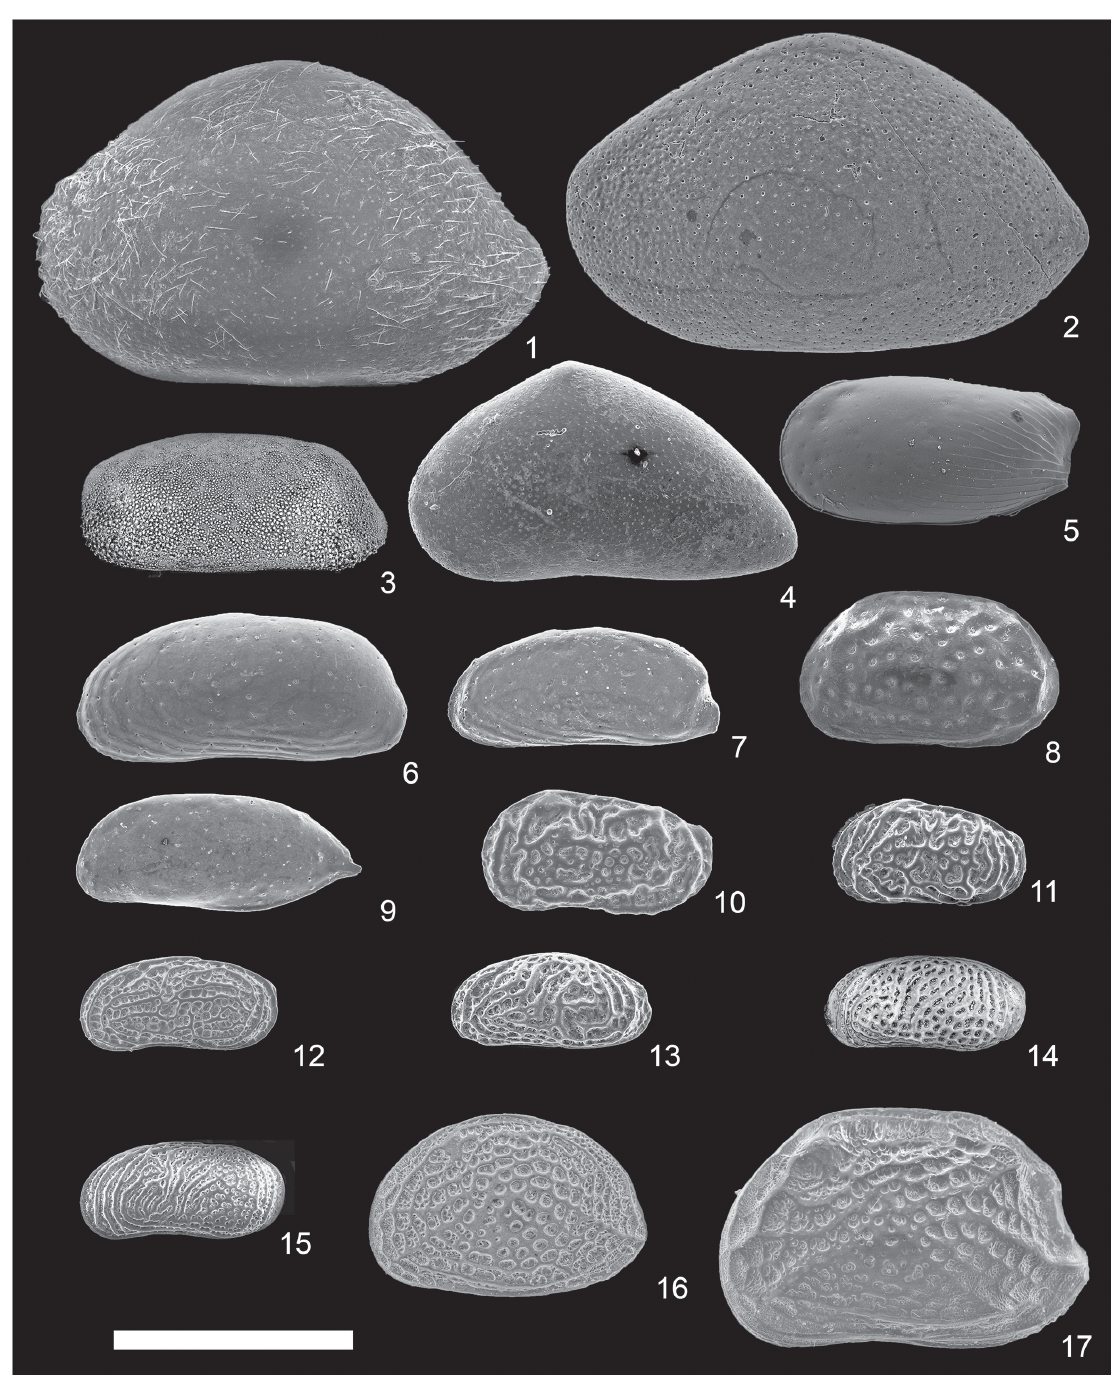
Figure 3. Scanning electron photomicrographs of the characteristic species in the Co To Islands. All specimens shown are the left valves. Scale bar is 500µm. (1) Neonesidea elegans s.l. (Brady, 1869) (from St. 6) (VNMN.0068); (2) Neonesidea sp. 1 (from St. 3) (VNMN.0069); (3) Mydionobairdia sp. (from St. 8) (VNMN.0070); (4) Propontocypris crocata (Maddocks, 1969) (from St. 8) (VNMN.0071); (5)